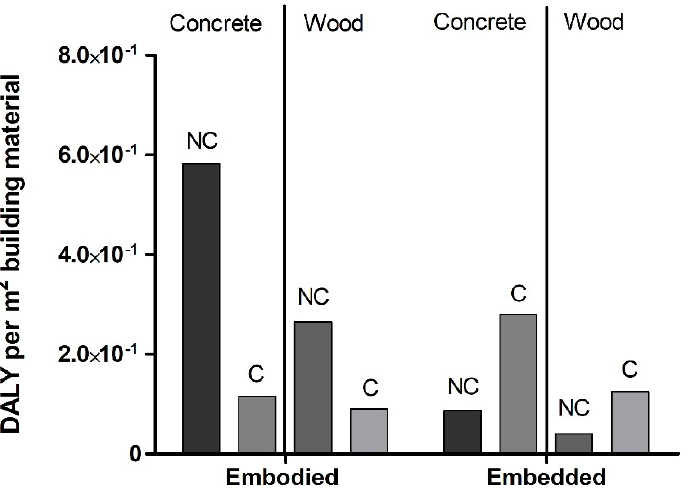
Figure 7. The final embodied and embedded human toxicity impact given for carcinogenic (C) and non-carcinogenic (NC) effects in DALY per m 2 building material. The final embodied and embedded human toxicity impact is separated between concrete and wood. The impact per m 2 wood and concrete are used for the comparison and selection of building materials in a real-world construction context.